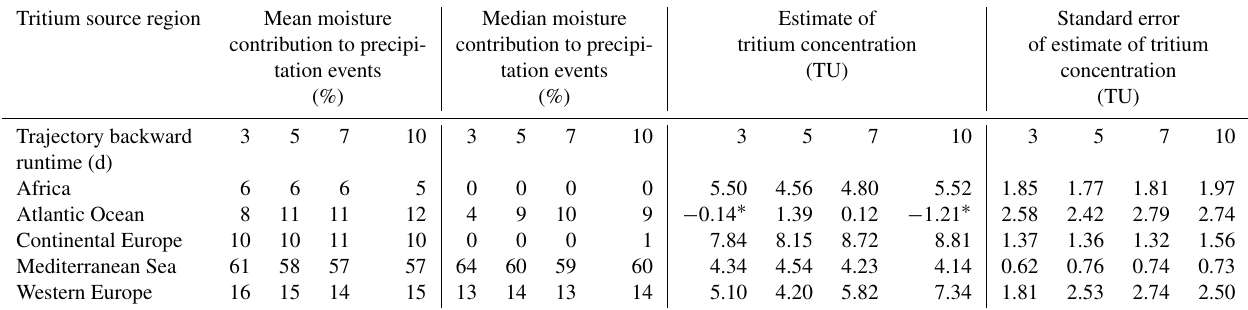
Table 2. Results for the relative moisture contribution and the estimation of tritium in source regions (as defined in Fig. 2) as calculated by Eq. (1) for different trajectory backward runtimes.